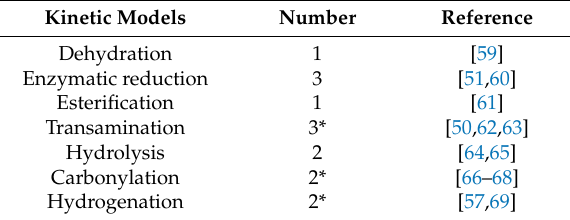
Table 10. Kinetic models availability; * indicates those that are included in the kinetic model